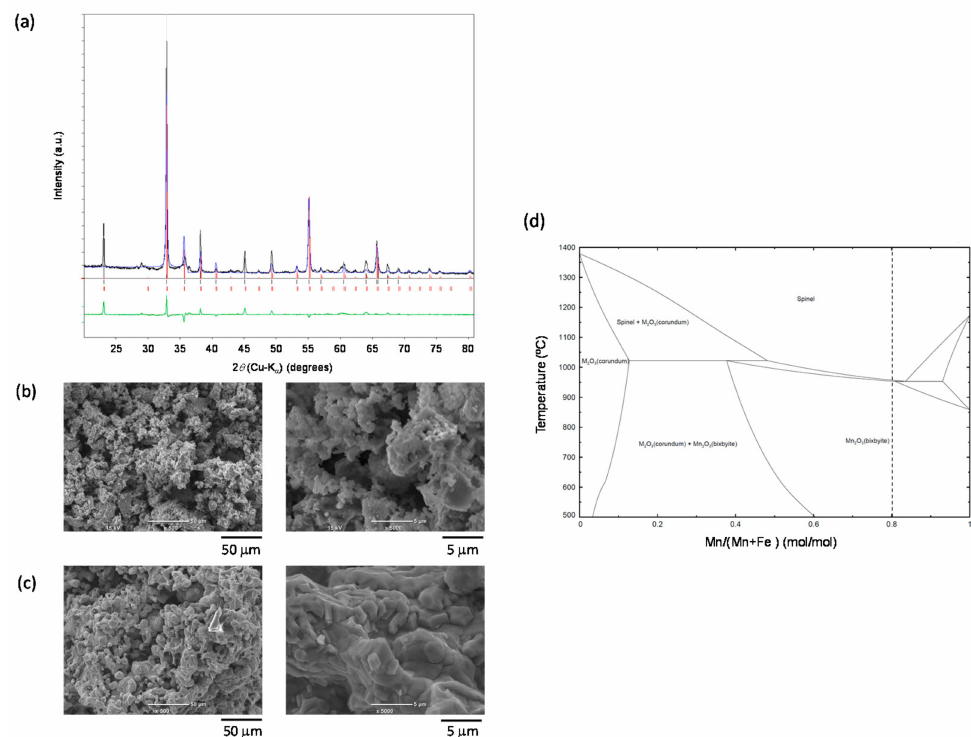
Figure 1. ( a ) XRD pattern of the Fe-substituted Mn 2 O 3 sample obtained after the long-term cycling test. The green curve below the XRD patters is a difference of intensity between experimental and Rietveld refinement of the structure model. ( b ) SEI images of the as-prepared sample. ( c ) SEI images of the sample obtained after the long-term test (360 runs of HC–HD cycle). ( d ) Phase diagram of the Mn-Fe-O system with an oxygen partial pressure of P O = 0.168 2